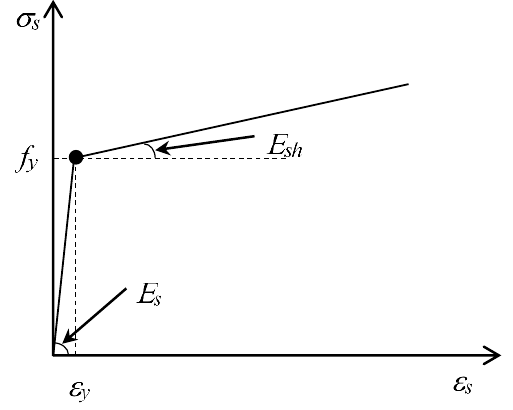
Figure 2. Stress–strain relationship of steel reinforcement.